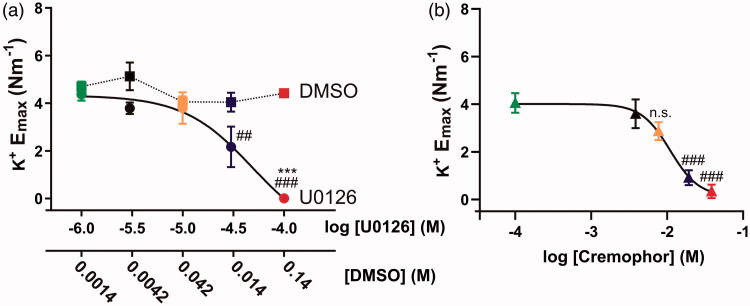
Concentration-dependence of U0126, DMSO, and cremophor on potassium-induced contractility after 48 h organ culture. Basilar arteries were incubated with different concentrations of U0126, corresponding concentrations of DMSO and cremophor. Correlation between the maximal 60 mM potassium contraction (K+ Emax) and the concentrations of U0126/DMSO (a) and cremophor (b). Values are listed in the Table S3, one-way ANOVA with Holm-Sidak post-test (##p < .01 and ###p < .001) or multiple t-tests with Holm-Sidak correction for multiple testing (***p < .001). Data are expressed as mean ± SEM, n = 4–15.